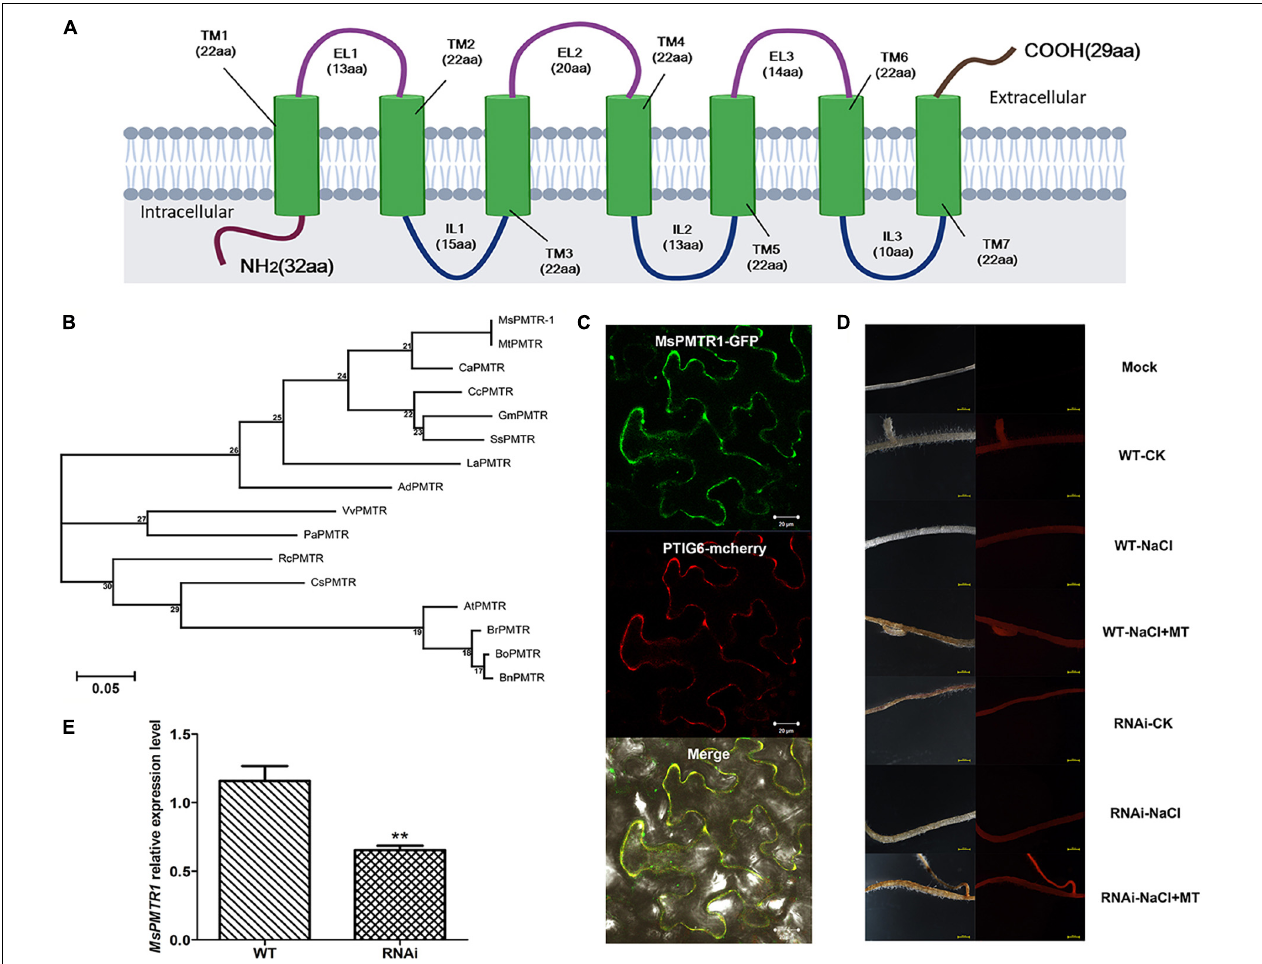
FIGURE 6 | Structural analysis of MsPMTR1 and silencing of it via hairy root transformation. (A) Predicted domain architecture of MsPMTR1 protein. (B) Phylogenetic analysis of PMRT1 homologs from different plant species. MsPMTR1 sequences were retrieved from Medicago sativa transcriptome data. All other sequences were identified from a public database, such as NCBI. The protein sequences were multiple compared using clustalW. MEGA 7.0 is used to build the phylogenetic tree through the maximum likelihood method, and the bootstrap method is used to verify the quality of tree building, with 1,000 times of inspection. MsPMTR1 , M . sativa , Cluster-15808.11987; MtPMTR , M . truncatula , P_013469022.1; CaPMTR , Cicer arietinum , XP_004495767.1; GmPMTR , Glycine max , XP_006589158.1; SsPMTR , Spatholobus suberectus , TKY52167.1; CcPMTR , Cajanus cajan , XP_020209653.1; LaPMTR , Lupinus albus , KAE9618996.1; AdPMTR , Arachis duranensis , XP_015939963.1; VvPMTR , Vitis vinifera , XP_002269068.1; PaPMTR , Prunus avium , XP_021817586.1; RcPMTR , Ricinus communis , XP_002512286.1; CsPMTR , Citrus sinensis , KDO42706.1; AtPMTR1 , Arabidopsis thaliana , OAP02387.1; BrPMTR , Brassica rapa , XP_009134806.1; BoPMTR , Brassica oleracea , XP_013629908.1; and BnPMTR , Brassica napus , XP_013684428.1. (C) Subcellular localization of MsPMTR1 . Nicotiana benthamiana leaves were infiltrated with Agrobacterium tumefaciens GV3101 containing pEarleyGate103-SL- MsPMTR1 vector, and the subcellular localization of GFP-fused MsPMTR1 was observed by confocal microscopy (Zeiss LSM710) under 635 nm red excitation light at 36 hpi. Plasma membrane marker protein, PTIG6 fused with mCherry is shown. (D) Confirmation of hairy root transformation by red fluorescent protein (RFP) expression. The left panel is the alfalfa hair root taken under natural light, and the right panel is the alfalfa hair root photographed under green excitation light (Wavelength = 558 nm). (E) Detection of MsPMTR1 gene knockdown by qRT-PCR experiment. The housekeeping gene, MsActin was used as the reference. Data represent mean values for three independent biological replicates. Standard errors are indicated by vertical bars. Asterisks indicate a statistical difference of the value at the ** P < 0.01 levels as determined by a t